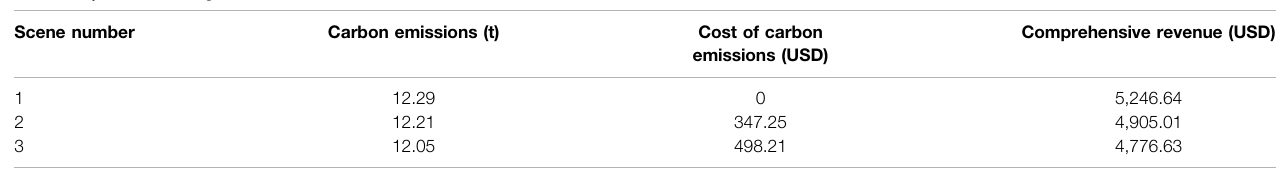
TABLE 5 | Carbon trading results.